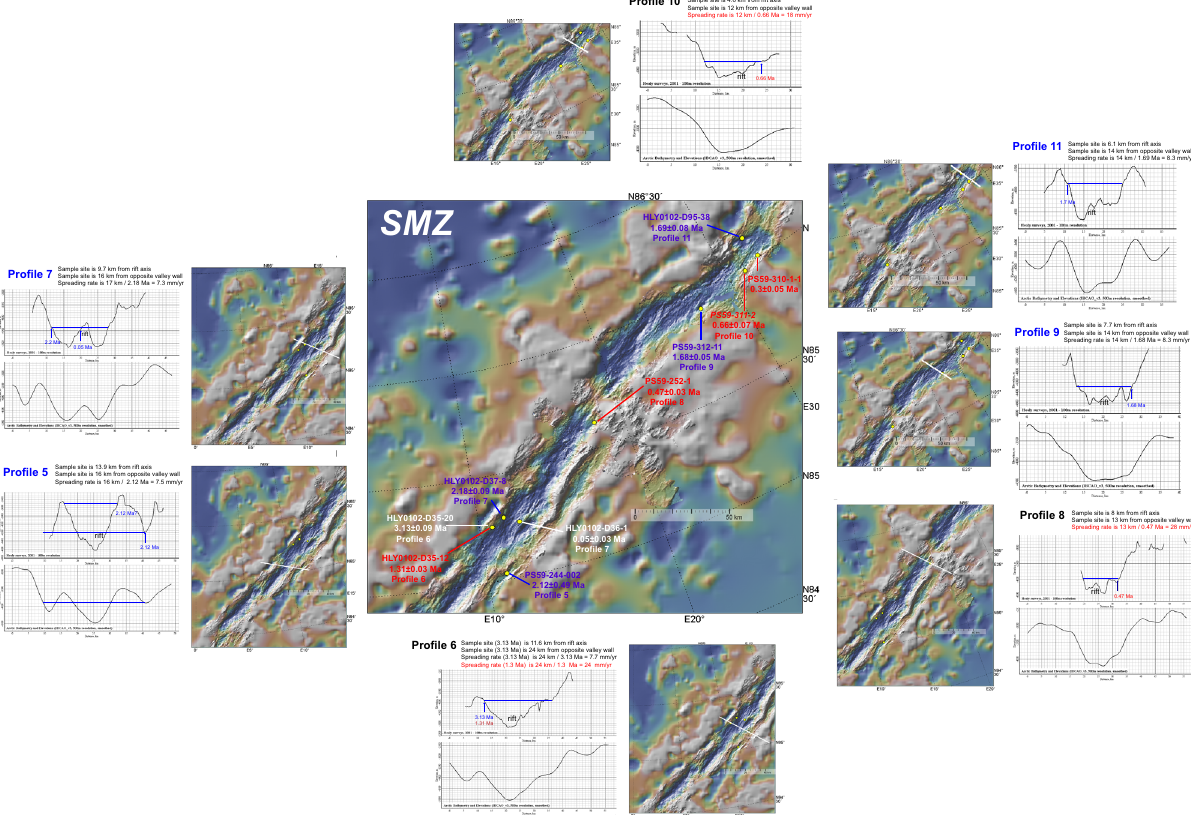
Fig. 3 Age-distance pro fi les in the SMZ. The SMZ is magma poor and magmatism can reach the surface away from the rift axis via large faults. P5 is oblique to the rift valley to connect the offset eastern tips of elongate fragments. A further complication is that the dredge sample was recovered on the side of a magmatic fragment facing away from the rift axis. Calculating the spreading rate from this location yields an anomalously fast-spreading rate of ~15 mm/yr compared to the rest of the pro fi les, particularly the nearby P6 and P7. The spreading rate is calculated from the crest of the fragment assuming that the dated sample re fl ects the age for the fragment as a whole. Red text is for samples from the valley walls yielding unrealistic young ages and spreading rates. For example, the dredge haul along P6 recovered basalts dated at 1.3 to 3.1 Ma. The anomalously young age is compatible with young basalts re fl ecting off-axis volcanism through faults. Blue text is for samples yielding coeval ages and matching spreading rates from opposite fl anks at the southern (P5 & P7) and northern (P9 & P11) end of the SMZ. Other details as in Fig.